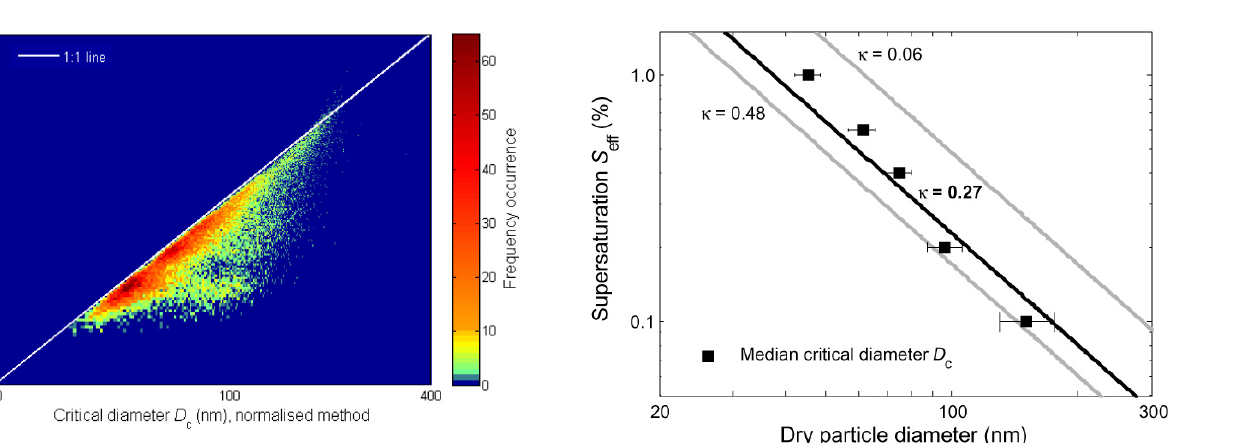
Fig. 5. Relationship between particle dry size (taken as D c ) and critical supersaturation S eff . The black and grey lines correspond to the global continental mean κ of 0.27 ± 0.21 as reported by Pringle et al. (2010), and the error bars are 25th and 75th percentiles of median D c